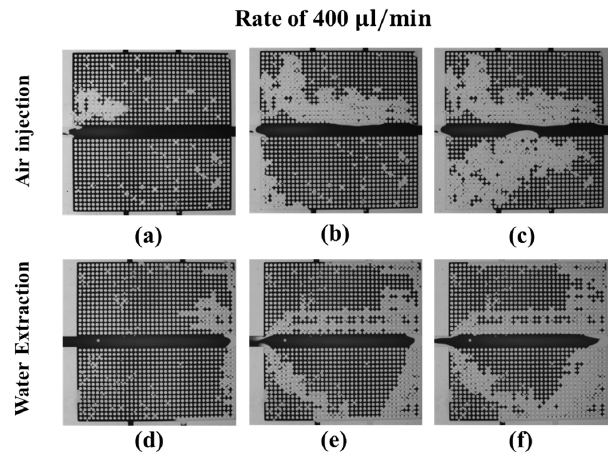
Figure 8. Dynamics of the water (dark)–air (transparent) distributions during the drainage process at an air-injection ( a – c ) and water-extraction ( d – f ) rate of 400 μ L/min; ( a , d ) correspond to the beginning, ( b , e ) to the middle, and ( c , f ) to the end of the drainage process.